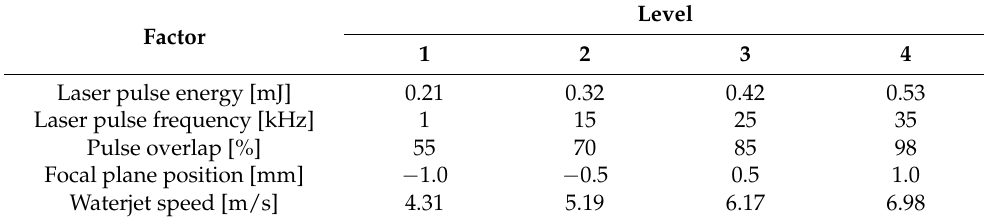
Figure 7. Experimental setup for CWALSM. Table 4. Configuration of experiment parameters.